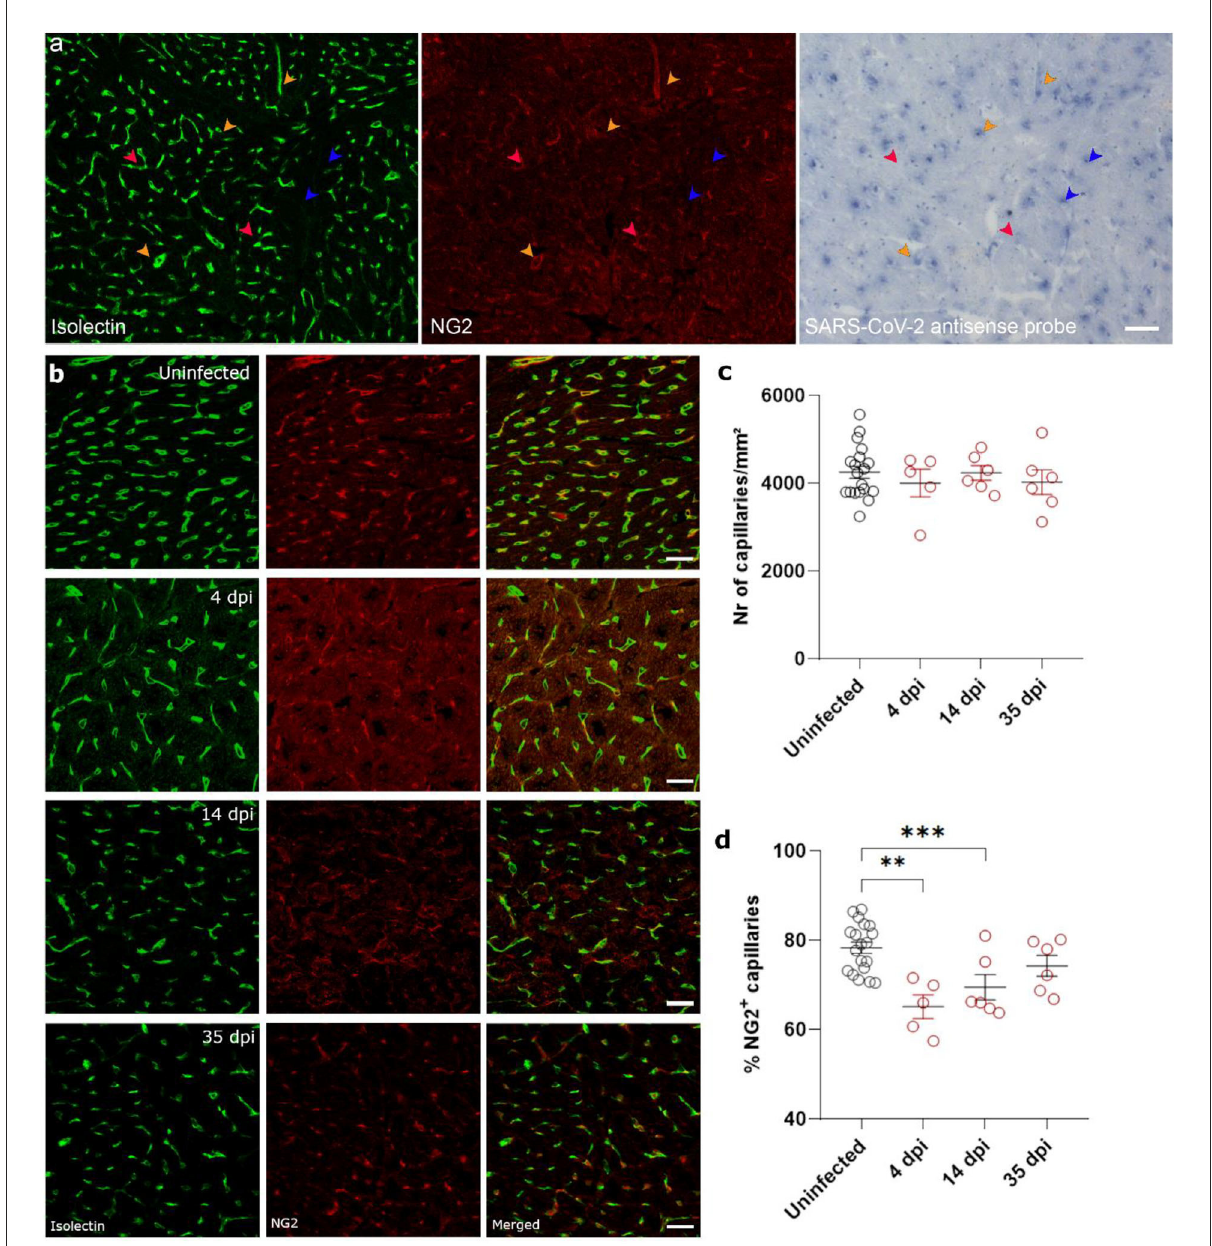
FIGURE4 SARS-CoV-2 infected hamsters lose their NG2 + pericytes at 4 dpi. Twelve week old hamsters were infected with SARS-CoV-2 virus and sacrificed 4 dpi, at the peak of viral load, 14 dpi, and 35 dpi. (a) SARS-CoV-2 infection was analyzed by in situ hybridization techniques in the left ventricle. Infected pericytes (yellow arrowhead), uninfected pericytes (red arrowhead), and other cell types that are infected (blue arrowheads) were present. (b–d) Left ventricle heart sections of age-matched control and infected hamsters were stained for Isolectin (green) and NG2 (red) to analyse the percentage of capillaries covered in pericytes (d) . NG2, neuron-glial antigen 2. Values are presented as mean ± SEM with n = 18 (uninfected) and 5-6 (SARS-CoV-2 infected hamsters). All data were analyzed using a one-way ANOVA followed by a Dunnett’s multiple comparison test with *** p < 0.001 comparing 14 dpi and 35 dpi hamsters to age-matched uninfected hamsters. Scalebar represents 50 µ m (a) and 20 µ m (b) .